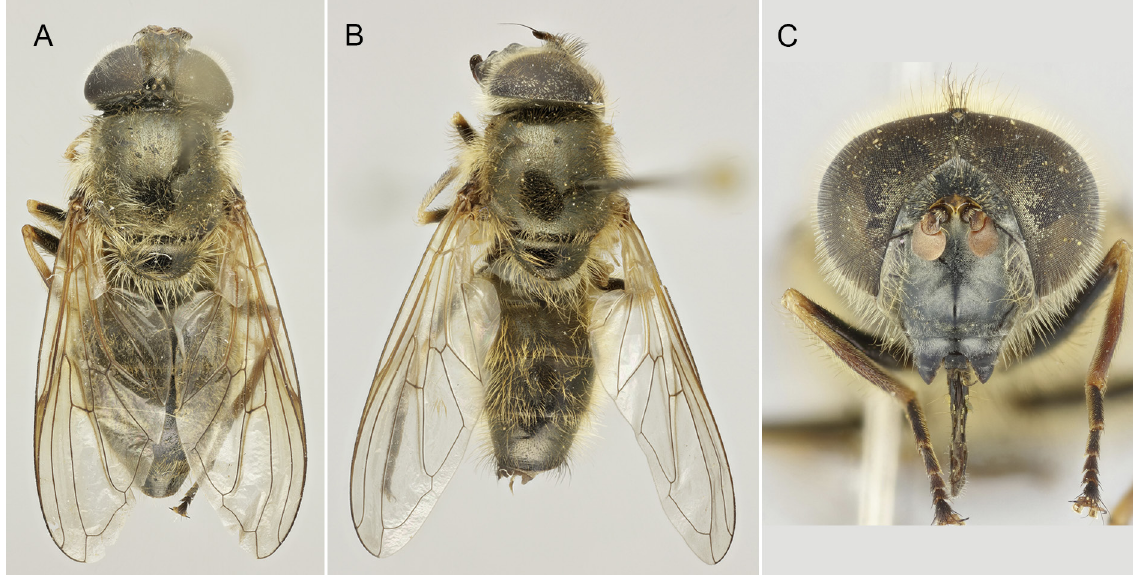
Fig. 19. Cheilosia ( Montanocheila ) erratica Barkalov & Peck, 1997. A . ♀ (IBSJW/NME), dorsal view. B . ♂ (IBSJW/NME), dorsal view. C . Male head (IBSJW/NME), anterior